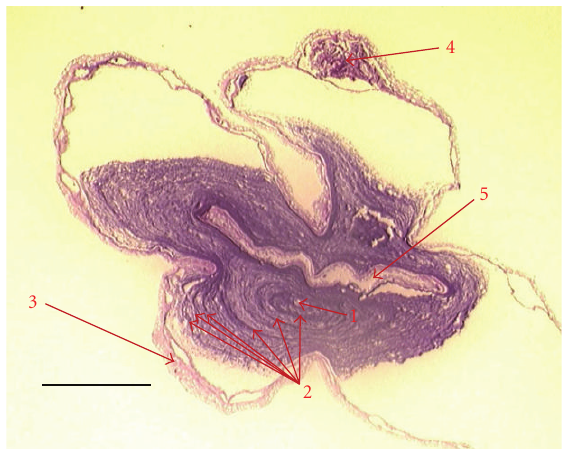
Figure 9: The transverse section of Paracorallium japonicum ; OCA-Cn20090504-039. 1: center of the axis, 2: growth rings, 3: coenenchyme, 4: autozooid, 5: associated commensal. Scale bar is 1.0mm.